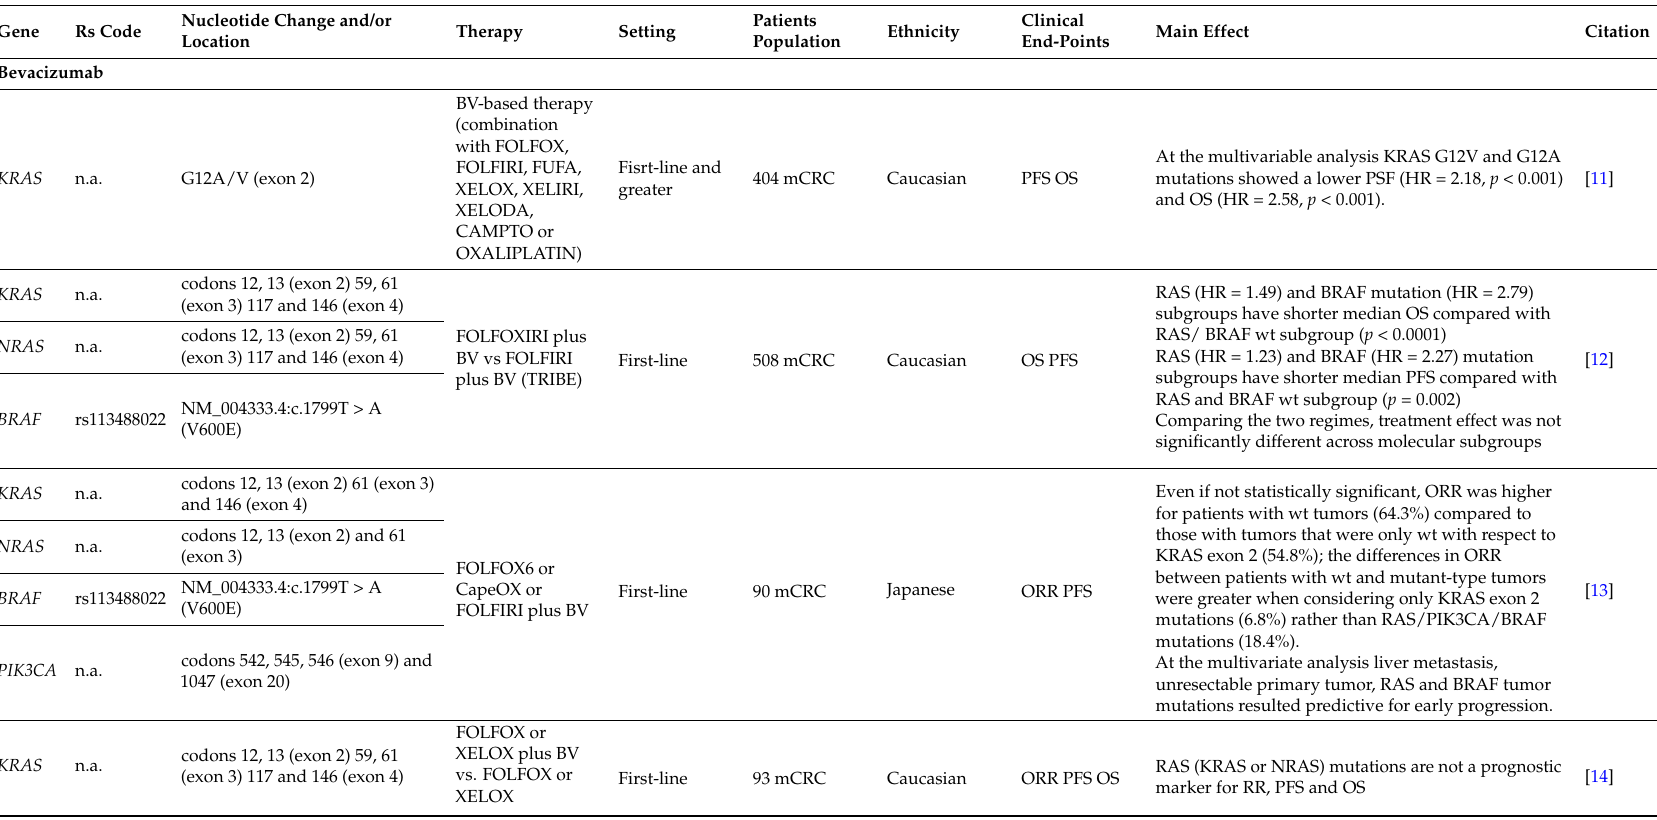
Table 1. Summary of published works on somatic mutations and efficacy of approved targeted